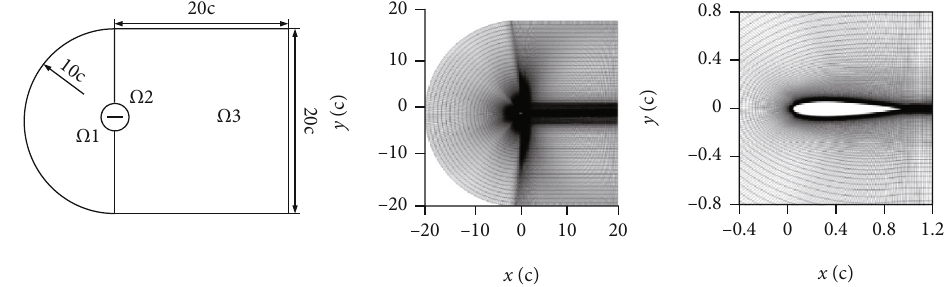
Figure 6: Grid topology for the NACA0012.